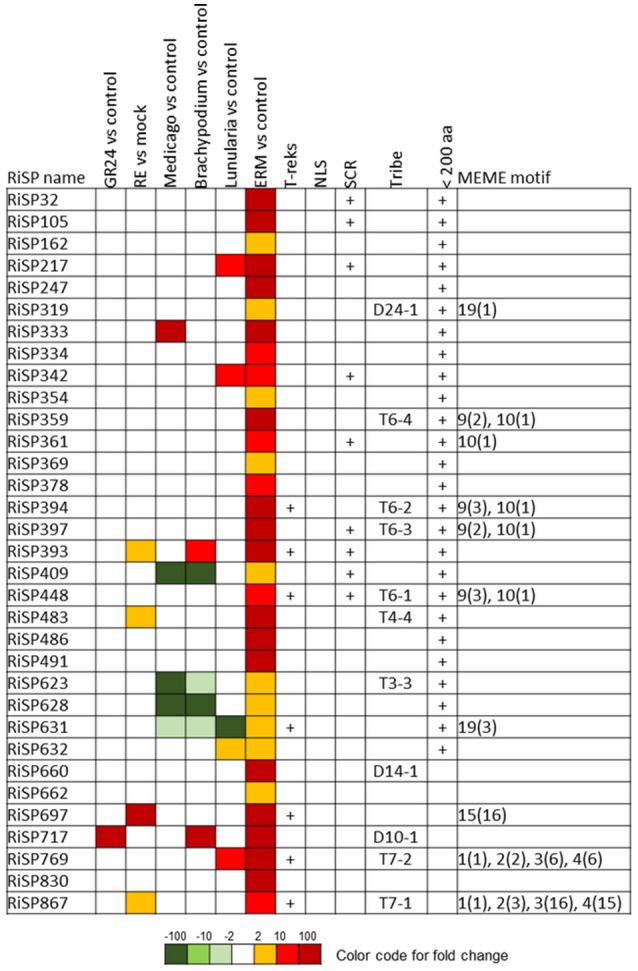
RiSPs of unknown function preferentially up-regulated in ERM. MEME motifs are described by their number (Figure 4 and Figure S2) and their occurrence (value within brackets).